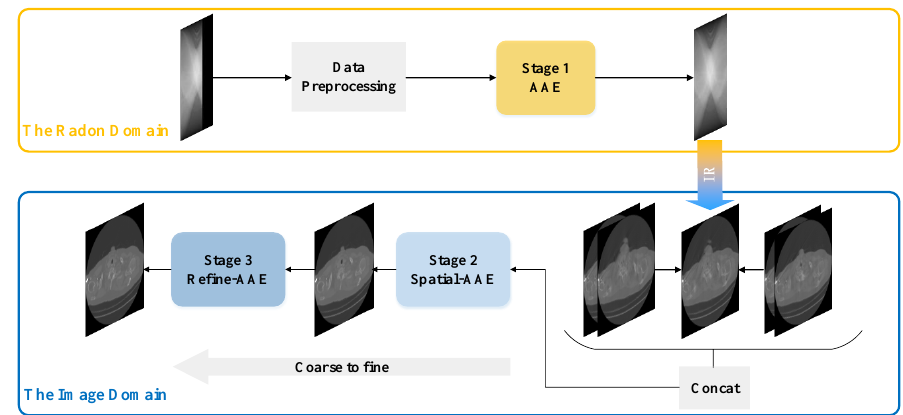
Figure 1. The overall architecture of our proposed method.